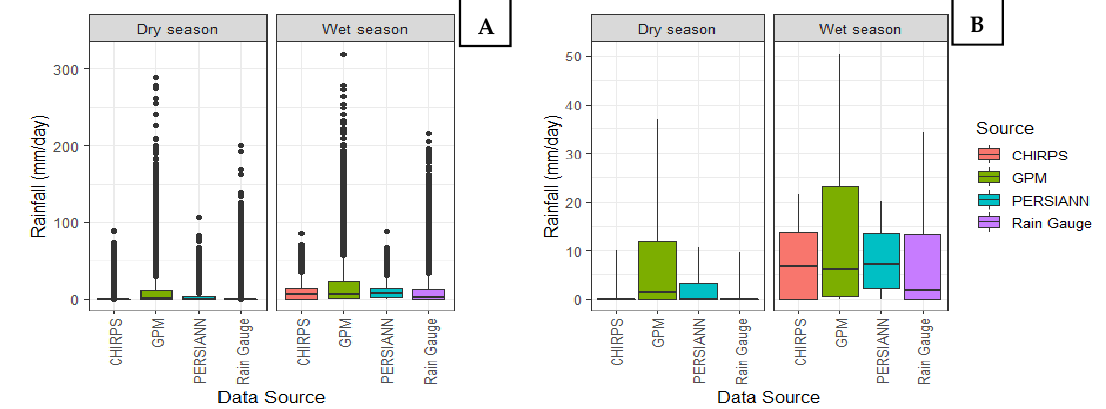
Figure 3. Scatter plots between rainfall from gauges and satellite products from all observation dates (1990–2020).